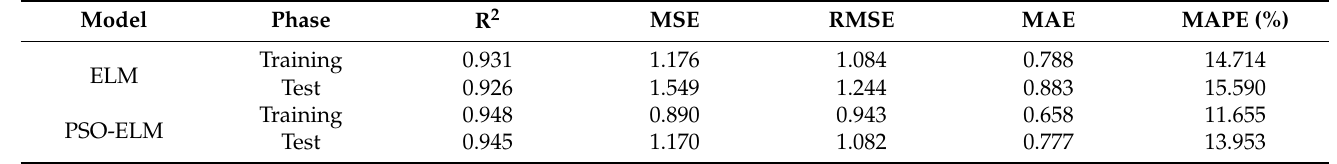
Table 3. Comparison of evaluation metrics for the prediction results of the two